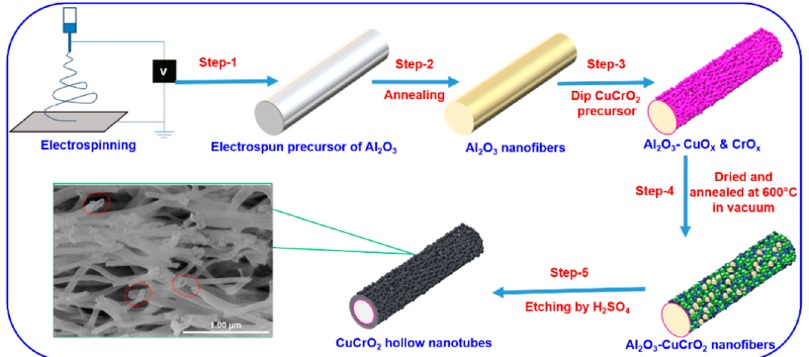
Figure 2. Schematic illustration of CuCrO 2 hollow nanotubes fabrication process.